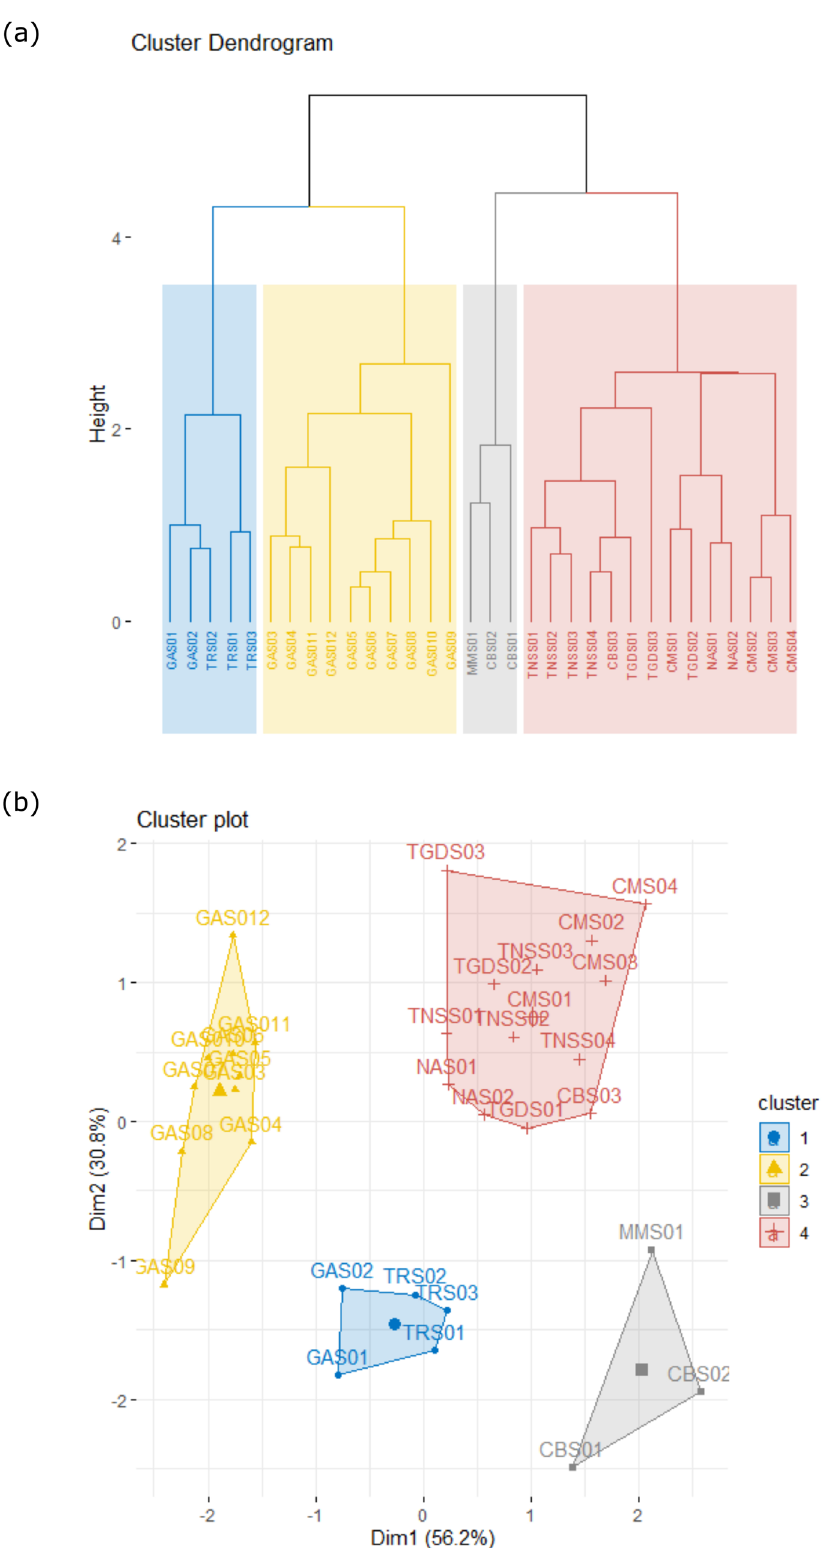
Fig. 1 Seasons: Hierarchical divisive clustering (DIANA). Cluster dendrogram ( a ) and cluster plot ( b ).